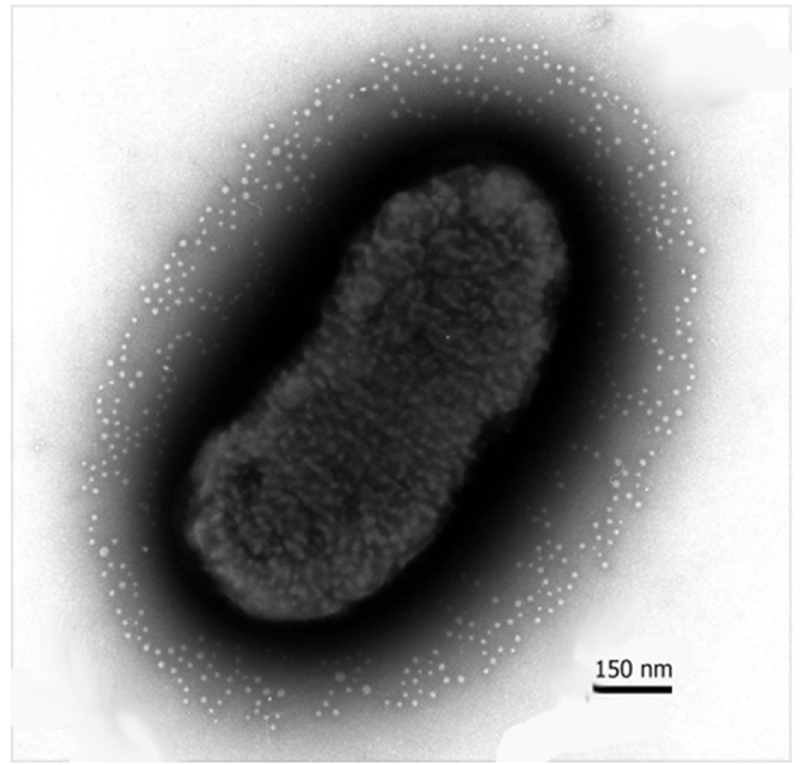
Figure 1. Electron micrograph of negatively contrasted bacterium Aeromons hydrophila H 1-6-05 (ammonium molybdate stain). Accumulations of numerous extracellular membrane nanovesicles on the surface, outside of bacterial cell, is presented. The spherical EMN are 20 to 50 nm in diameter. (Material is provided by Konstantin A. Lusta).